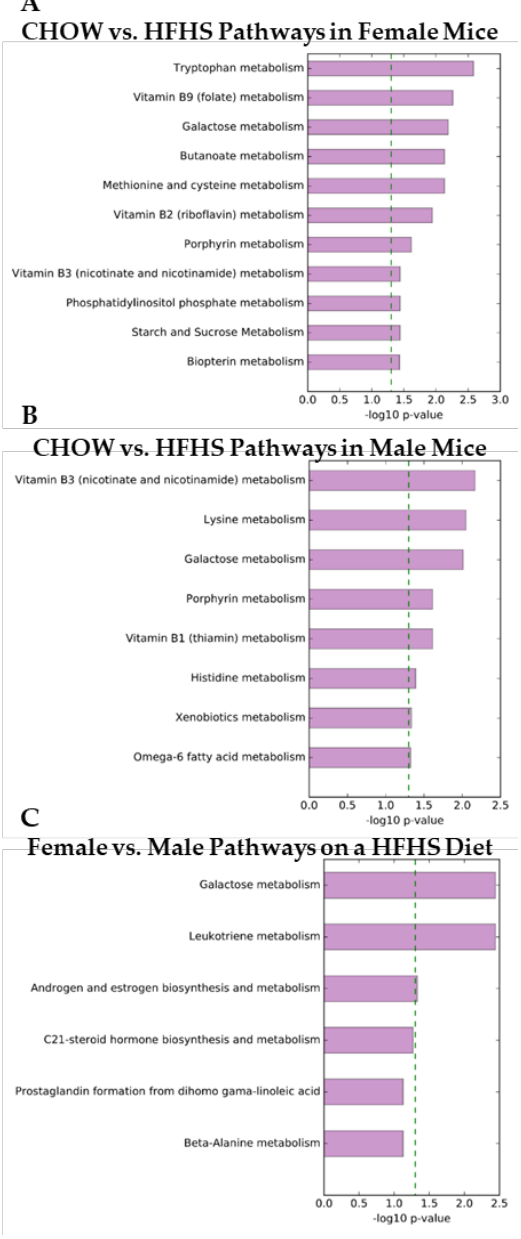
Figure 3. Mummichog Pathway Analysis. Generated bar graphs depict detected metabolite pathways that had altered metabolites at a significance level of p < 0.0025. ( A ) Eleven detected pathways were altered between diets in female mice. ( B ) Eight detected pathways were altered between diets in male mice. ( C ) Three detected pathways were altered between sexes fed an HFHS diet.